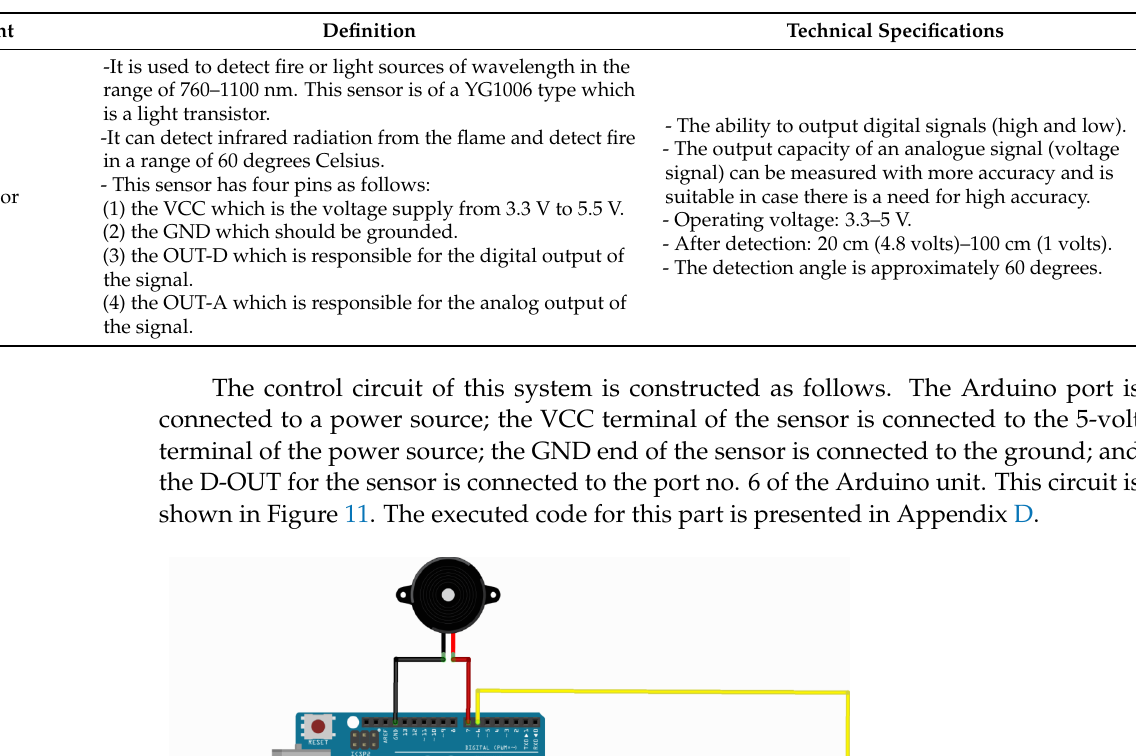
Figure 10. The graphical user interface on the phone for controlling the fire alarm system in the smart home. Table 5. The main components for the fire alarm system in the smart home.